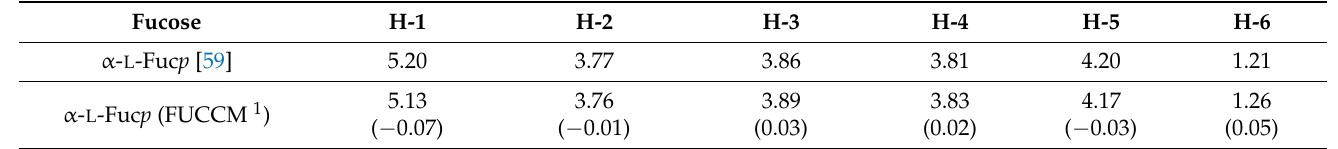
Table 5. 1 H NMR chemical shifts of fucoidan extracted from C. myriophylloides (FUCCM) and sulfated fucopyranoses